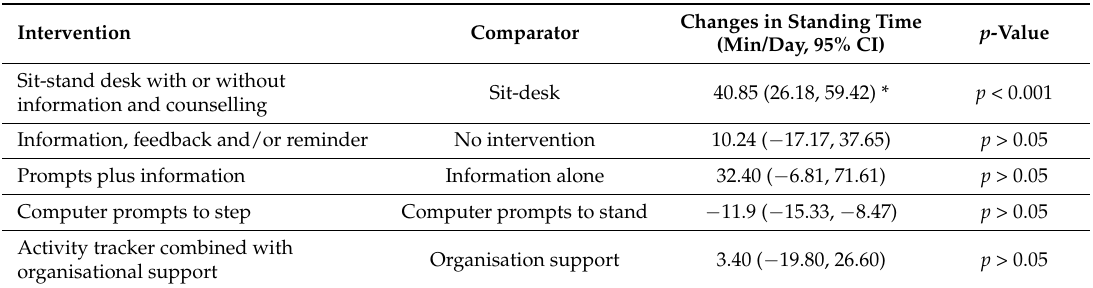
Table 1. Meta-analysed results of reduction in standing time for different types of workplace